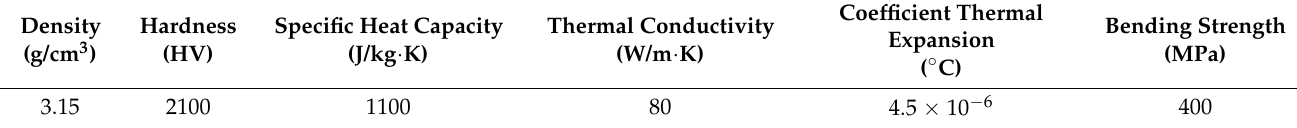
Table 1. Performance indicators of SiC.